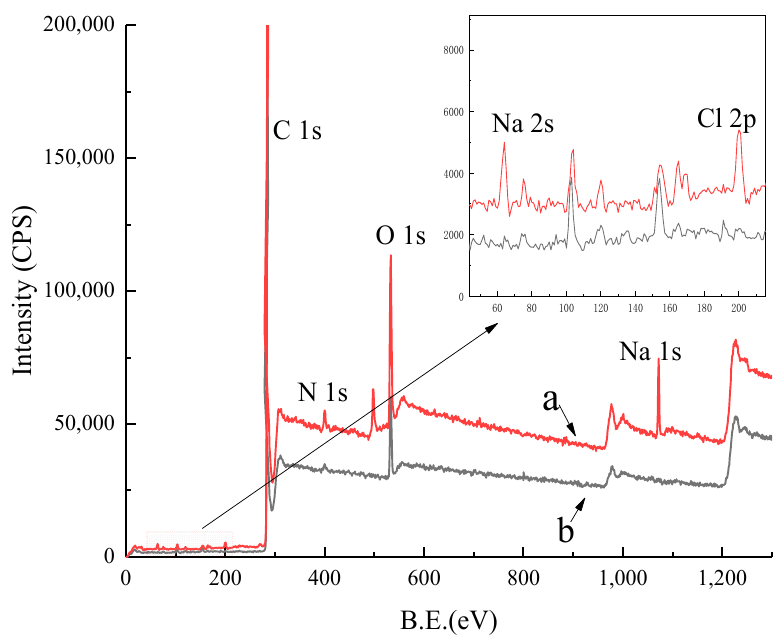
Figure 10. The X-ray photoelectron spectroscopy and partial enlargement of coking coal after adsorption